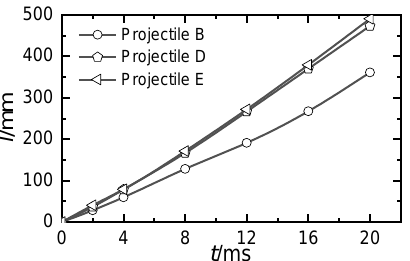
Figure 9. Sequence diagram of simulated launching process under different groove numbers ( p max = 9.9 MPa).